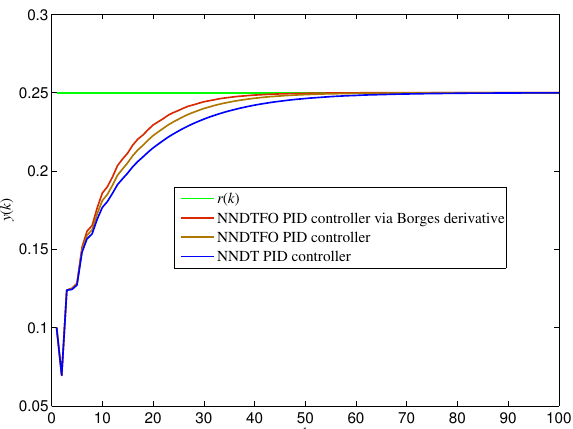
Figure 11. Responses of outputs y ( k ) via three types of PID controller using the closed loop system of example 2 with a constant